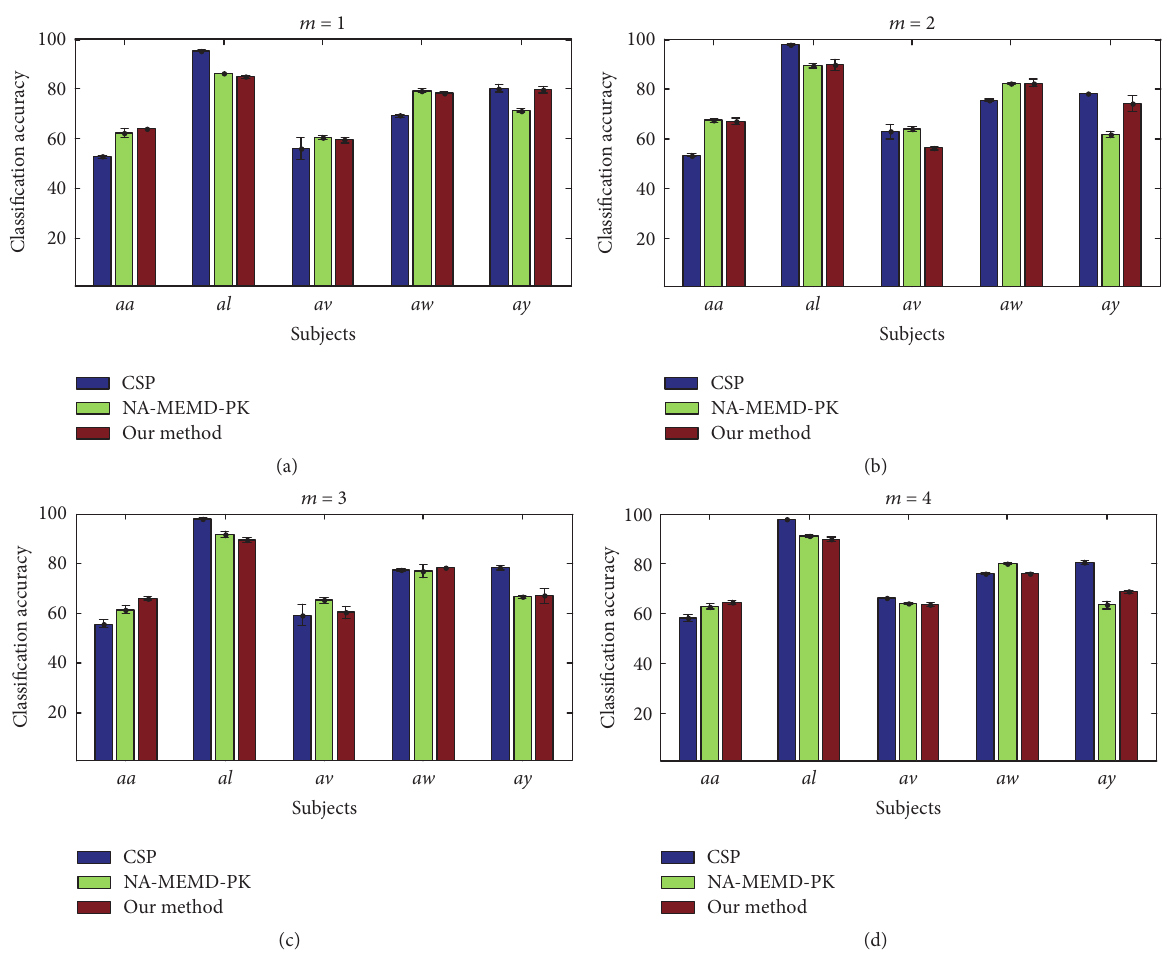
Figure 8: Classification accuracies (mean and standard deviation) obtained for the five subjects of BCI Competition III Dataset IVa when 𝑚 = 1, 2, 3, 4 , respectively.